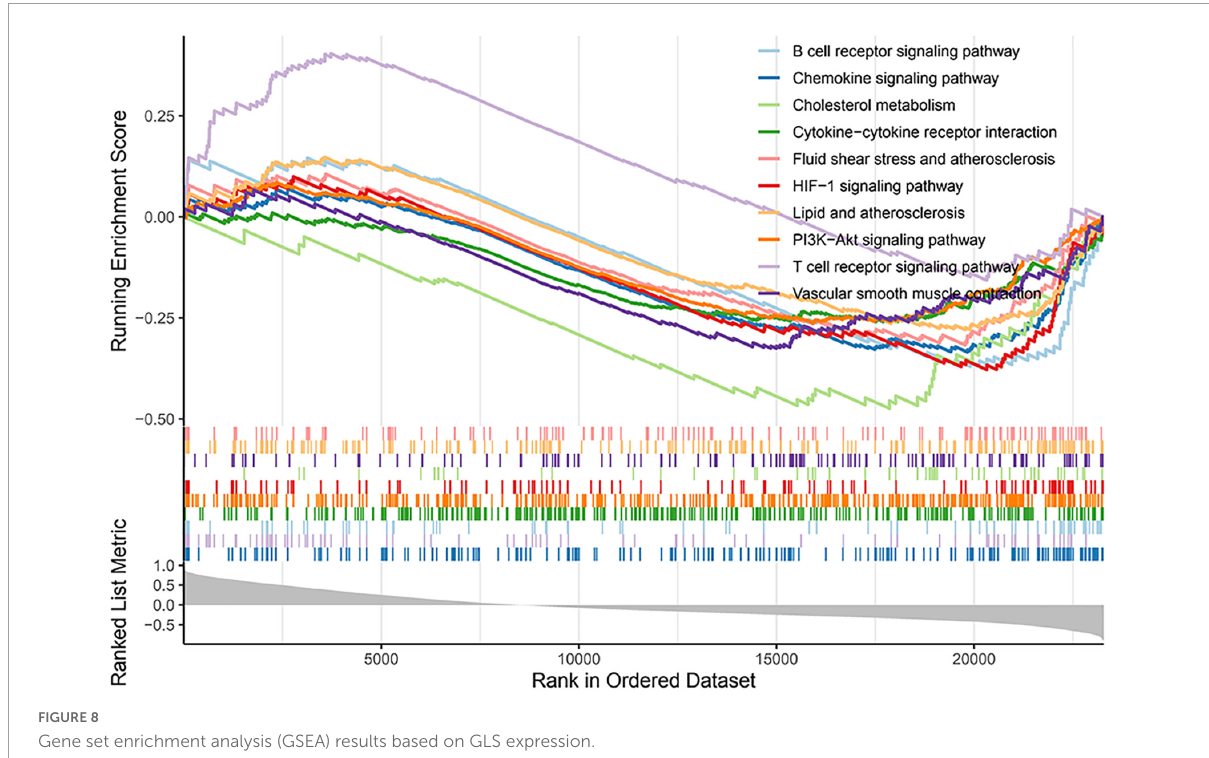
FIGURE8 Gene set enrichment analysis (GSEA) results based on GLS expression.